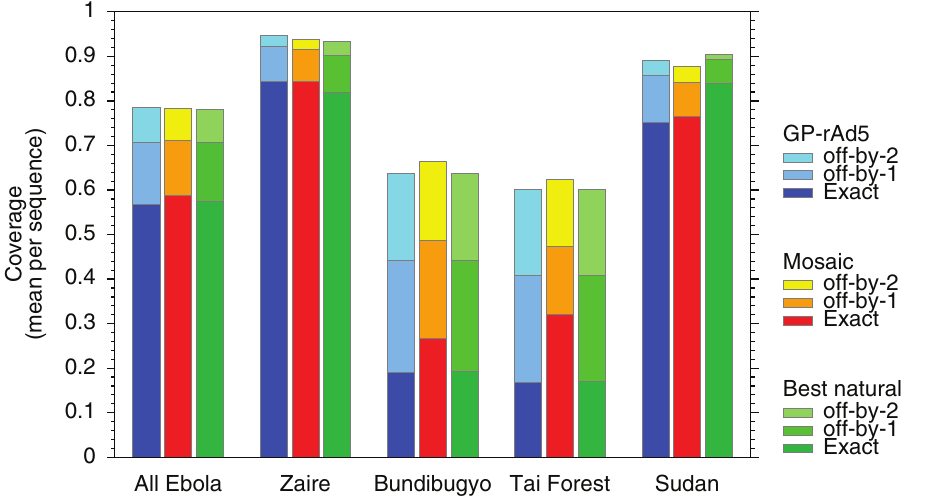
Figure 3. Comparison between vaccine strategies. The computed epitope coverage by the Hensley et al. GP-rAd5 vaccine proteins, the two 2- protein mosaic cocktail, and the two best-natural proteins. The 2-protein mosaics and best-naturals were optimized against the ebolaviruses excluding Reston virus. The plotted results include Reston virus in the genus-wide coverage results.